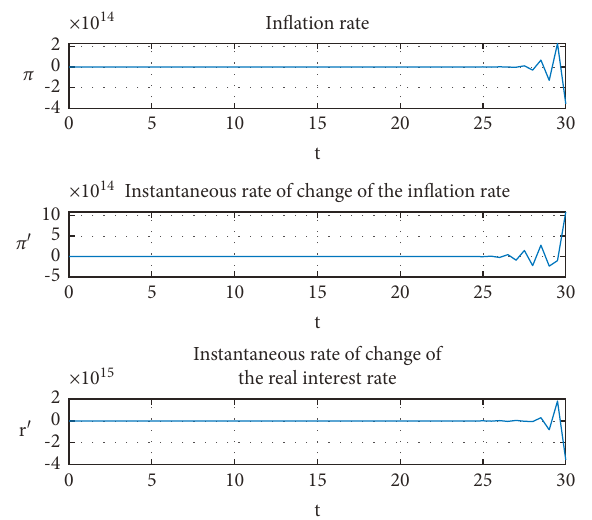
Figure 18: Time paths of the interest rate and instantaneous rates of change of inflation and the interest rate (for I 1 and with β 19 β 0 ). (cid:31) >